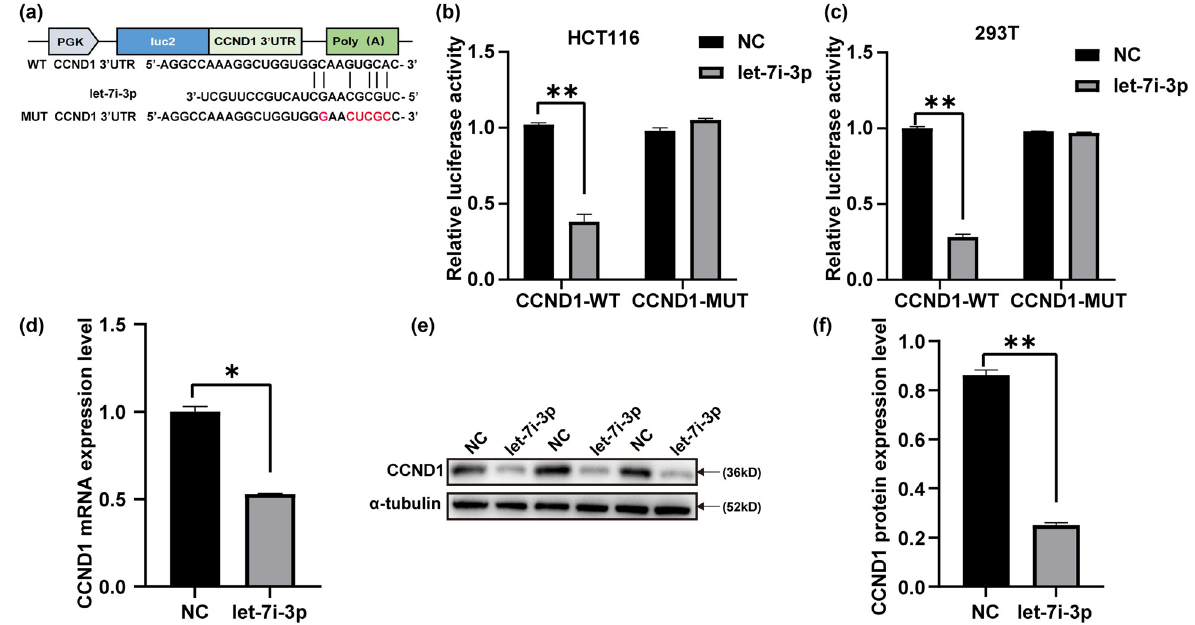
Figure 3: Let - 7i - 3p directly targets CCND1. ( a ) Putative WT and mutant ‐ type ( MUT ) let - 7i - 3p target sequences of CCND1 mRNA 3 ′ - UTR. ( b and c ) Relative luciferase activity in HCT116 and 293T cells co - transfected with constructs carrying WT or mutant - type CCND1 mRNA 3 ′ - UTR with let - 7i - 3p or NC. ( d and e ) The overexpression of let - 7i - 3p in the HCT116 cells attenuated the expression of CCND1 mRNA and protein levels, respectively, and a statistical histogram was shown at right ( f ) . * P < 0.05 and ** P <